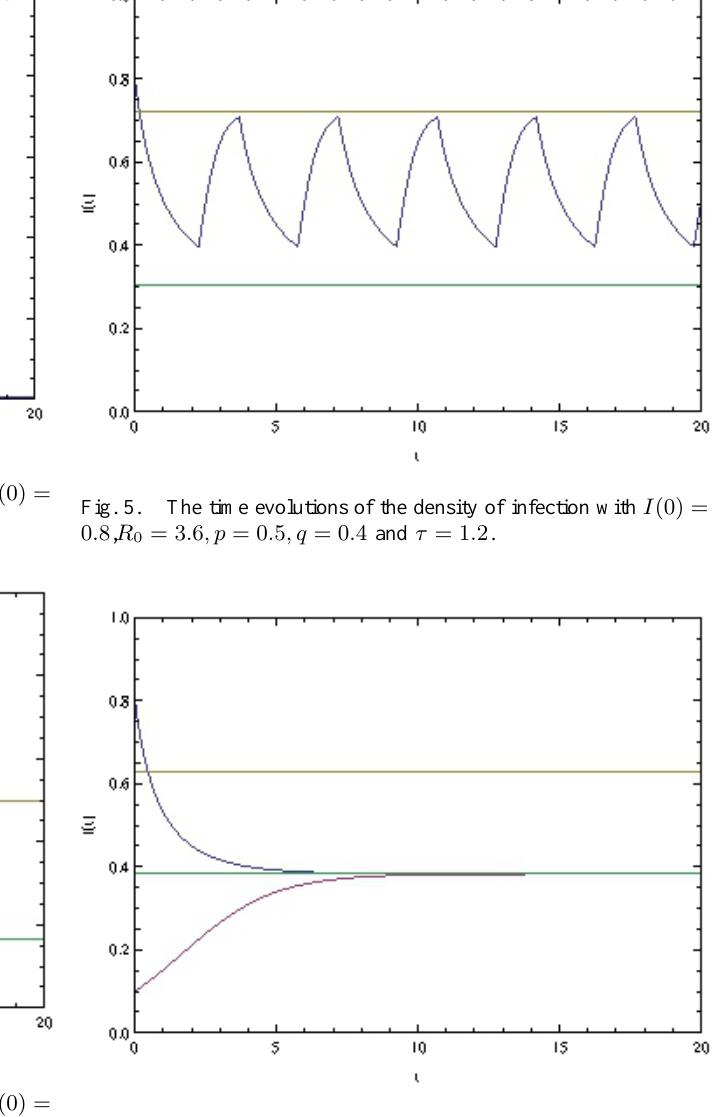
The time evolutions of the density of infection with I (0)